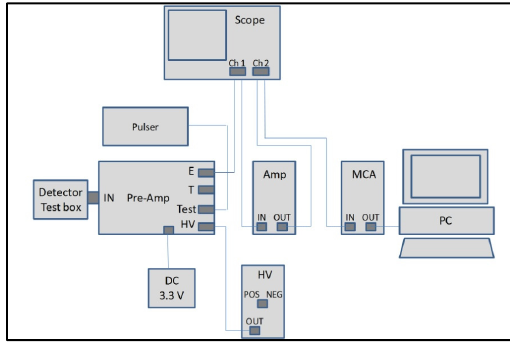
Figure 7. Schematic of the radiation detection set-up.